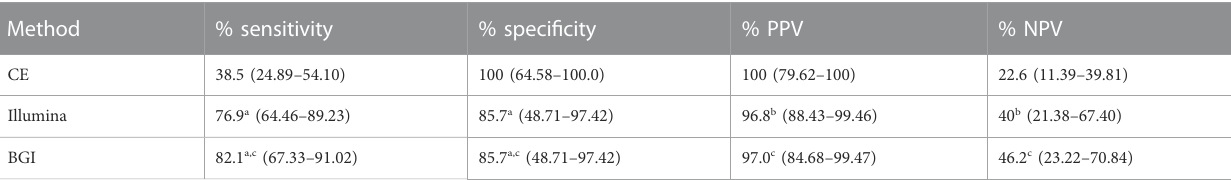
TABLE 2 Comparison of the sensitivity and speci fi city between the mNGS platforms (BGI and Illumina platform) and conventional examinations.